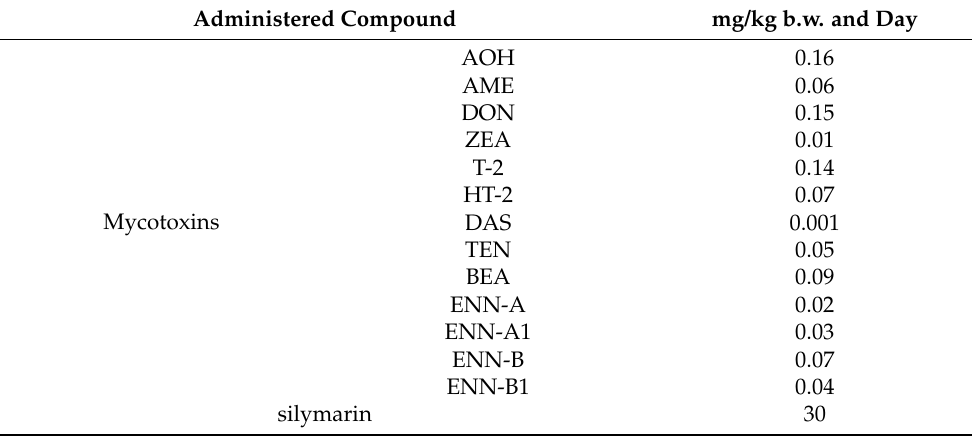
Table 1. The administered doses of mycotoxins and silymarin in mg/kg b.w. and